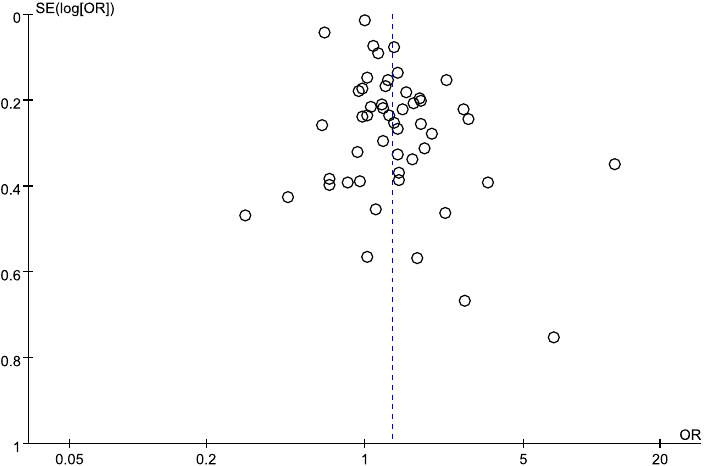
Table 3 and Figure 5. The random-effects model meta-analysis indicated a significant association between SW and LBP in HCWs (OR: 1.40, 95% CI: 1.20–1.63, p < 0.00001), while no significant association was found between SW and LBP in non-HCWs (OR: 1.19, 95% CI: 0.94–1.50, p = 0.14).